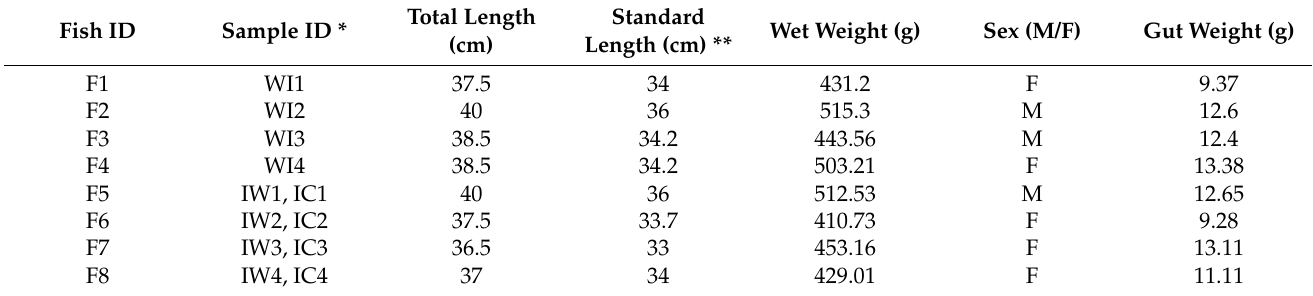
Table 1. Physiological details of the collected